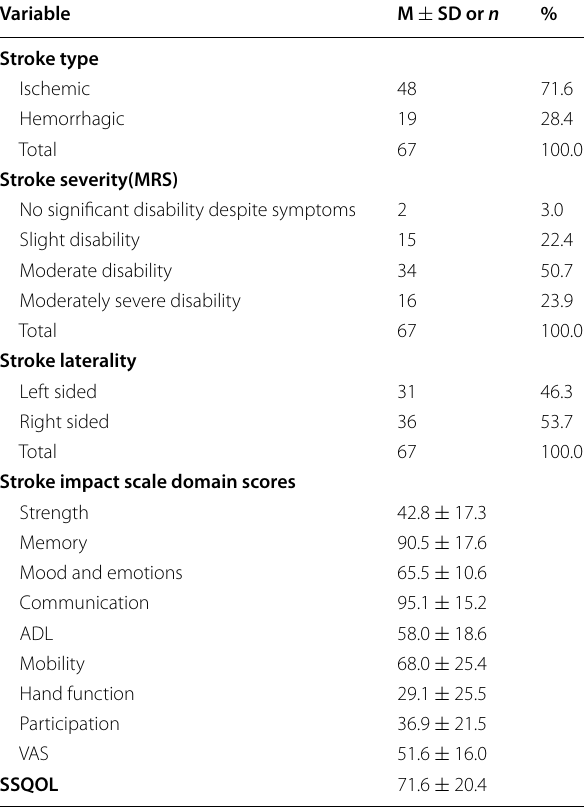
Table 2 Descriptive statistics of clinical features and